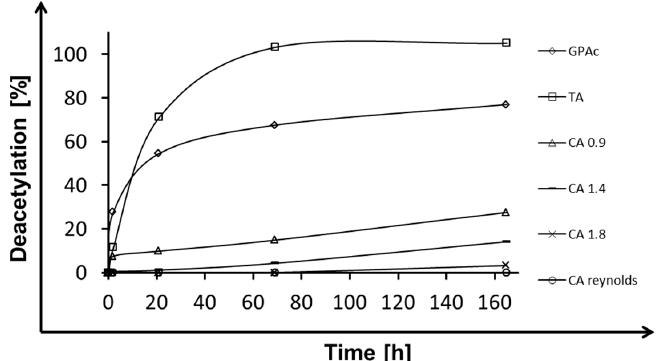
Figure 3. Deacetylation of cellulose acetate with different degree of substitution (DS) and model compounds by pectin acetyl esterase (PAE) after 168 h of incubation. Glucose pentaacetate (GPA); Triacetin (TA)